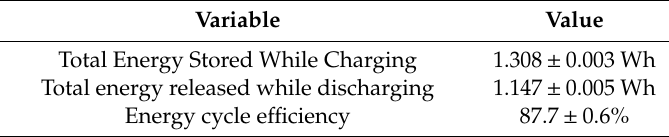
Table 10. Results for energy calculation in the hydraulic